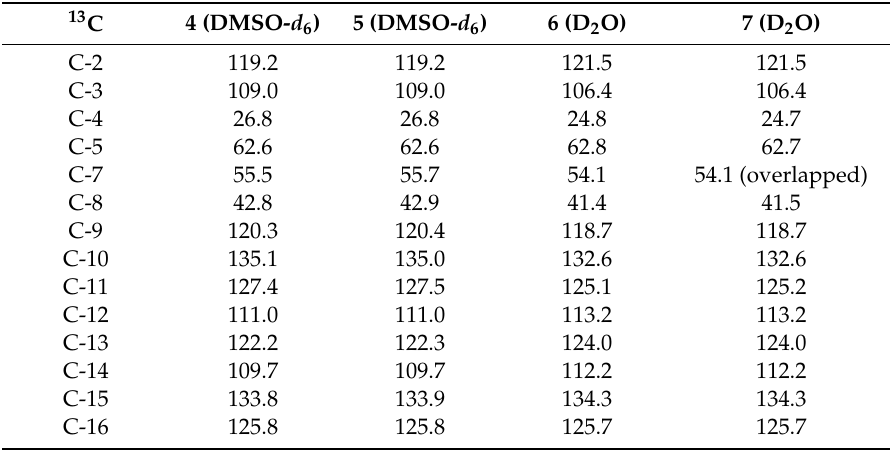
Table 2. 13 C NMR chemical shifts (ppm) a of compounds 4 – 7